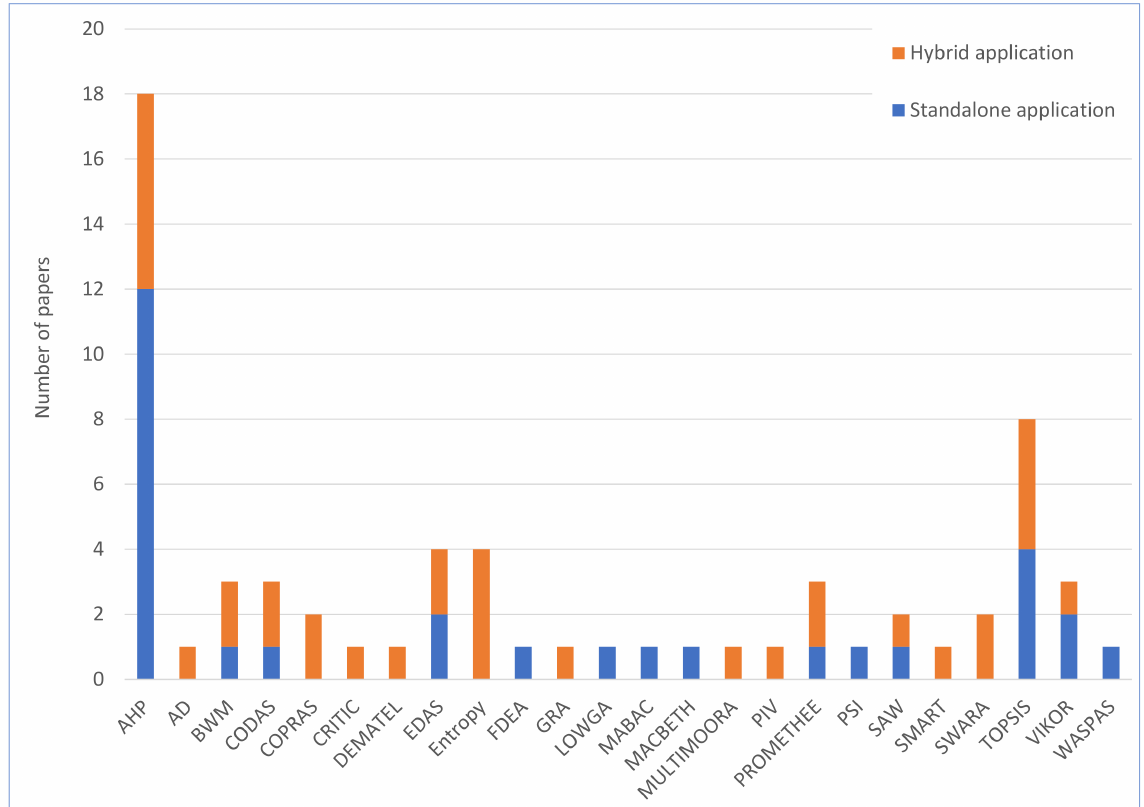
Figure 1. The number of papers found applying each MCDM